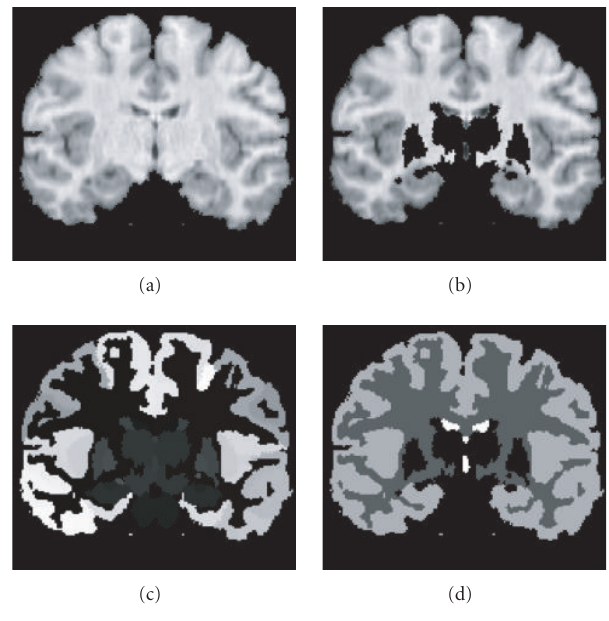
Figure 3: MRI brain data. (a) Original slice with cortical structures. (b) Original data with noncortical structures removed. (c) Manually labeled data on cortical structures. (d) Simplified manually labeled data used for the “ground